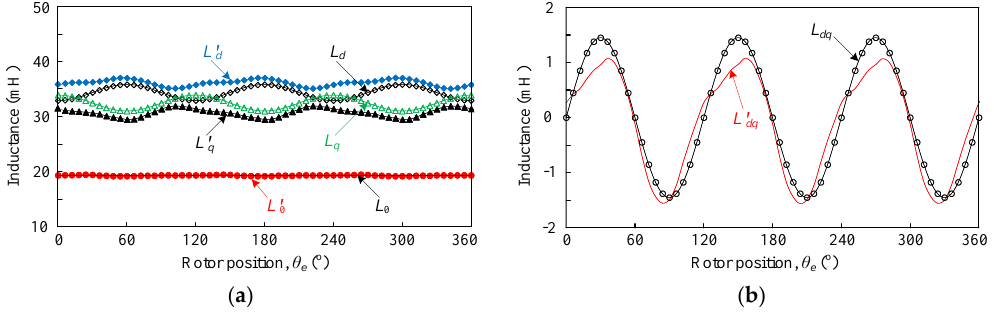
Figure 7. Waveforms of inductance. ( a ) Self-inductance in d-q axes frame, L d , L q , L 0 , L ’ d , L ’ q , and L ’ 0 ; and ( b ) mutual inductance in d-q axes frame, L dq and L ’ dq . Table 3. Average values of inductance in d-q axes frame.